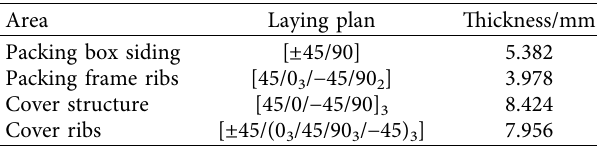
Table 3: Packaging layer and thickness